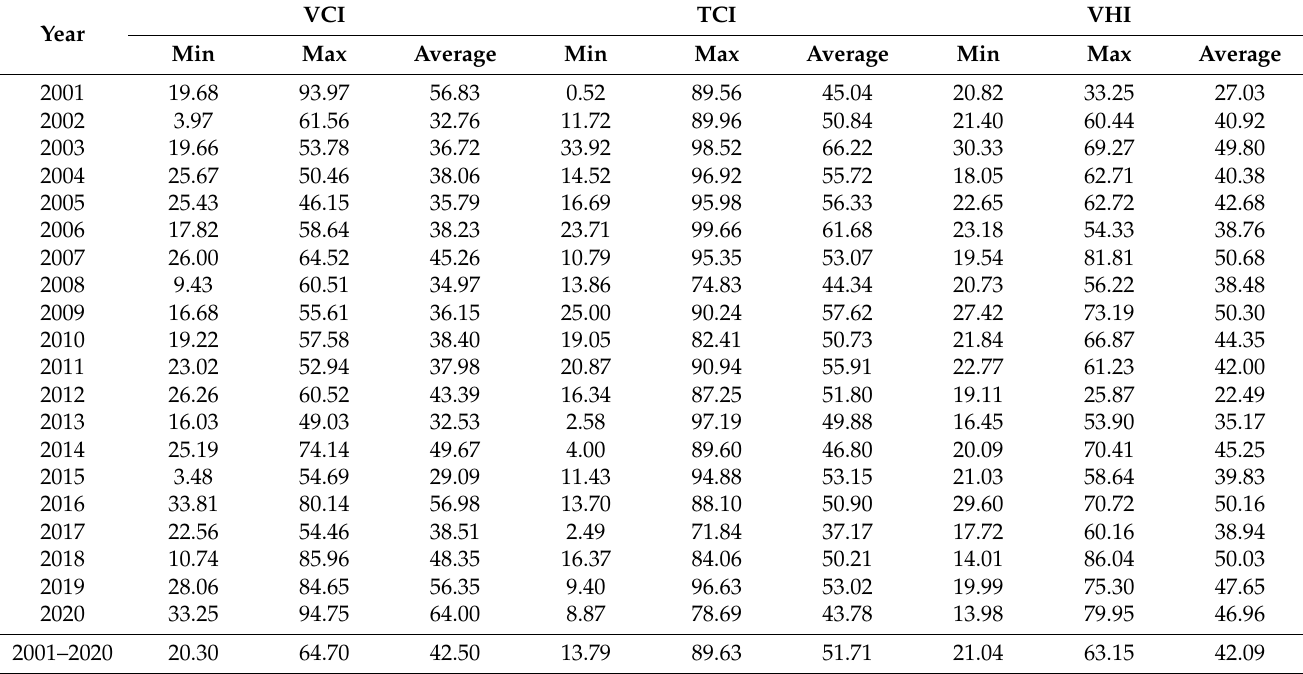
Table 4 . Minimum, Maximum, and Mean values of VCI, TCI, and VHI (2001 – 2020).